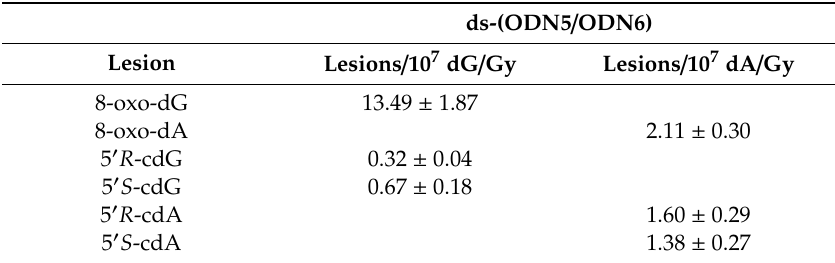
Figure 11. Radiation induced formation of 8-oxo-dG, 8-oxo-dA, 5 (cid:48) R -cdG, 5 (cid:48) S -cdG, 5 (cid:48) R -cdA, and 5 (cid:48) S -cdA in double-stranded 21-mer oligonucleotides; Each sample was exposed to 0, 20, 40 and 60 Gy dose in N 2 O-saturated aqueous solutions. The values represent the mean ± SD of n = 3 independent experiments. Table 3. The levels (lesions / 10 7 nu / Gy) of 8-oxo-dG, 8-oxo-dA, 5 (cid:48) R-cdA, 5 (cid:48) S-cdA, 5 (cid:48) R -cdG and 5 (cid:48) S -cdG in irradiated ds-ODNs.